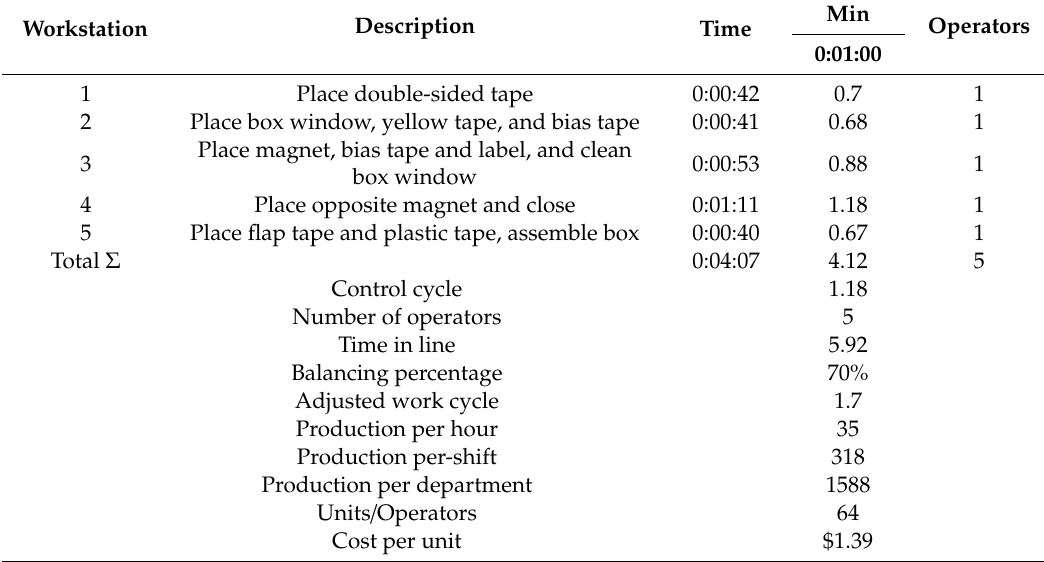
Table 5. Cost per unit—line balancing analysis results.